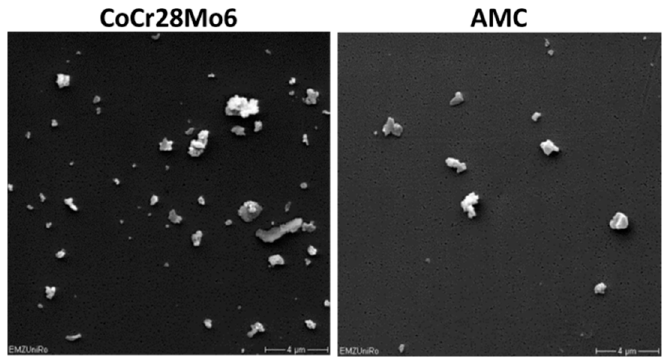
Figure 7. Representative FESEM pictures of CoCr28Mo6 and AMC particles (scale bar: 4 µm).